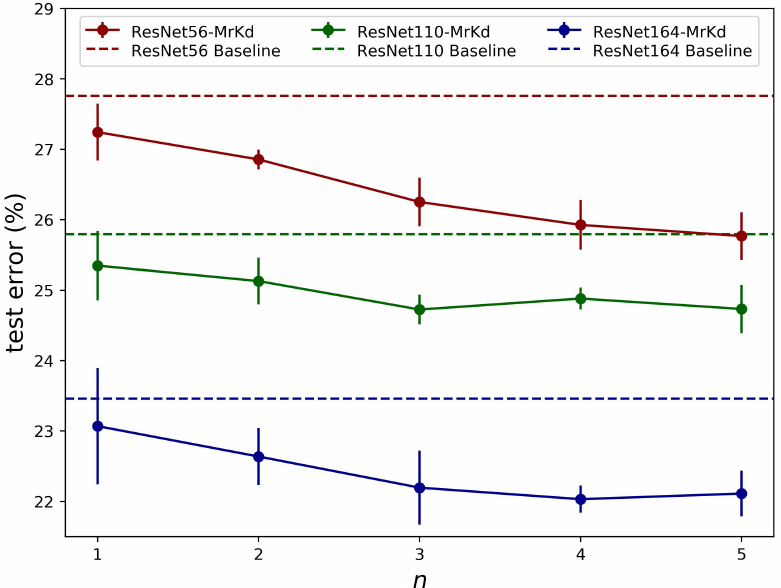
Figure 8. Performance on CIFAR-100 with different copy amount n